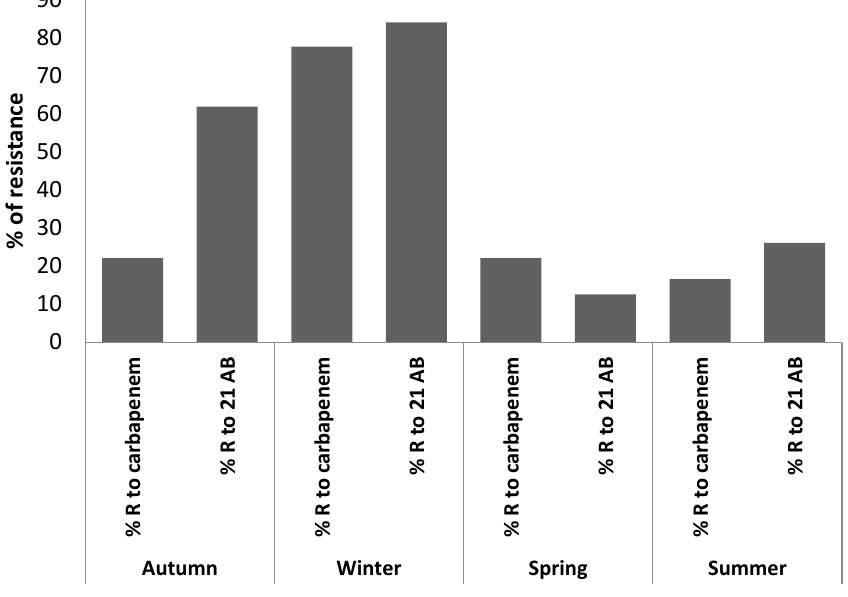
Figure 1. Graphical representation of the Predicted Environmental Concentration ( ■ ) (in mg/L): in comparison with the percentage of Carbapenem-resistant bacteria ( ■ ) (in %) in ArzH. Figure 2 present the seasonal variation of antibiotic resistance AMR in hospital ef- fluent Ar-razi Hospital. The AMR in hospital effluent bacteria for carbapenems and also the 21 other ABs studied varies according to the seasons, indeed it is maximum in winter (84.11%) for the 21ABs and (77.78%) for carbapenems, and during the other seasons the percentage of AMR does not exceed 62% as the maximum value and is detected for the 21 ABs and decreases to 12.70% and is detected for the carbapenems.